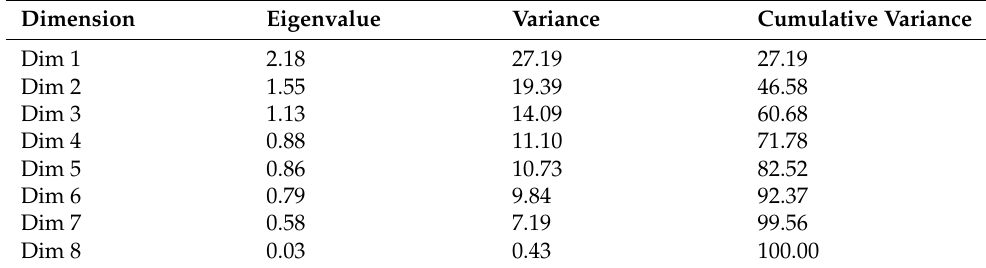
Table 9. Eigenvalues, variances and cumulative variances of the study dimensions. Dimension Eigenvalue Variance Cumulative Variance